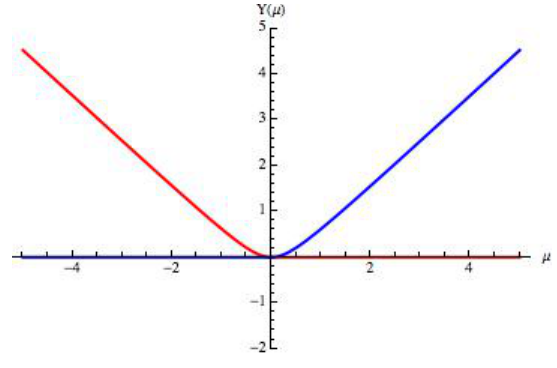
Fig. 1. Transcritical bifurcation around µ = 0 . Unstable equilibrium (red), and Stable equilibrium (blue).